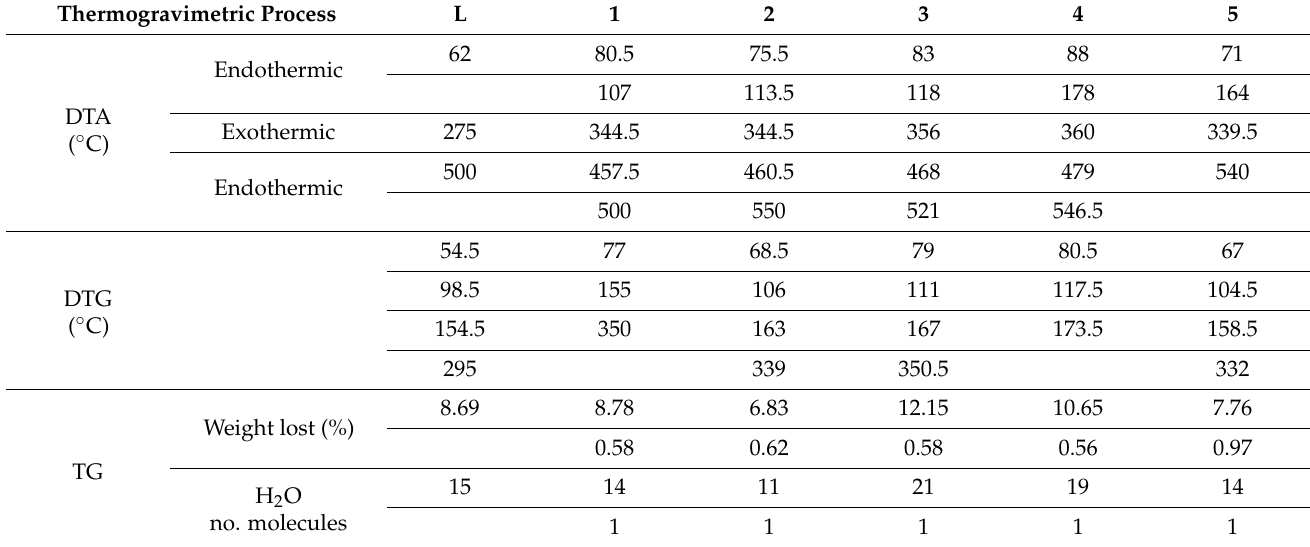
Table 1. Thermogravimetric data of ligand L and complexes 1–5